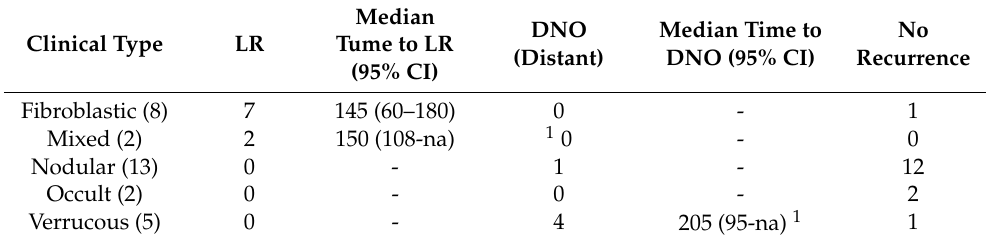
Table 2. Follow-up information for 30 horses with sarcoids, according to the clinical type.